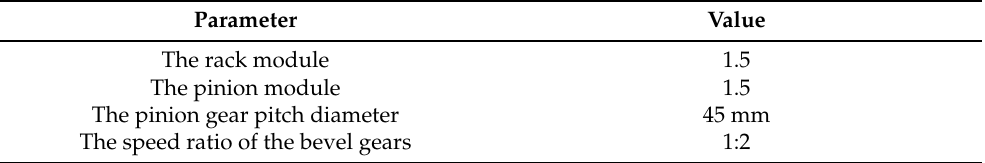
Table 1. The transmission parameter